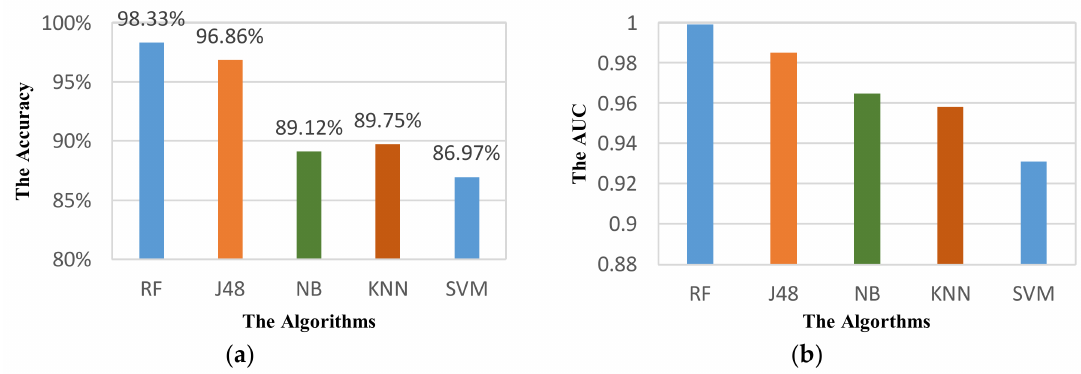
Figure 9. Performance of VDM with the optimized parameters: ( a ) Accuracy; ( b )